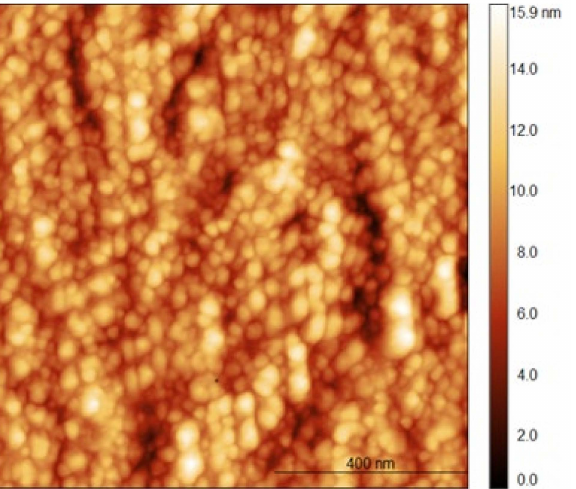
Figure 2. AFM image of NCH+Zn. Image size is 1 × 1 µ m 2 . Result previously published in